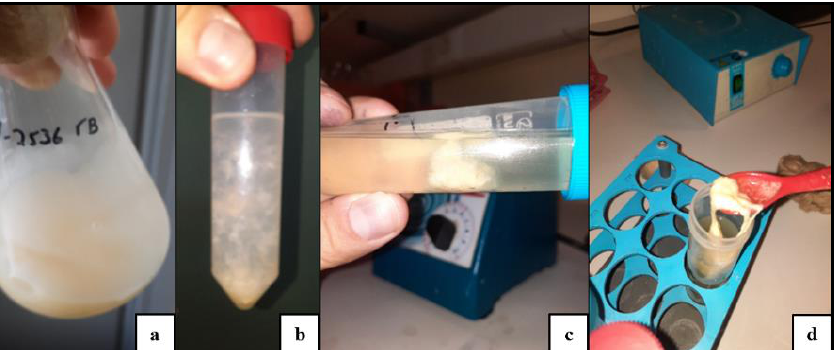
Figure 2. The viscous culture broth of Papiliotrema laurentii NRRL Y-2536 cultivation ( a ), after the addition of acetone ( b ), forming a blur ( c ), which precipitates ( d ), resulting in a thick, elastic, gummy precipitate.